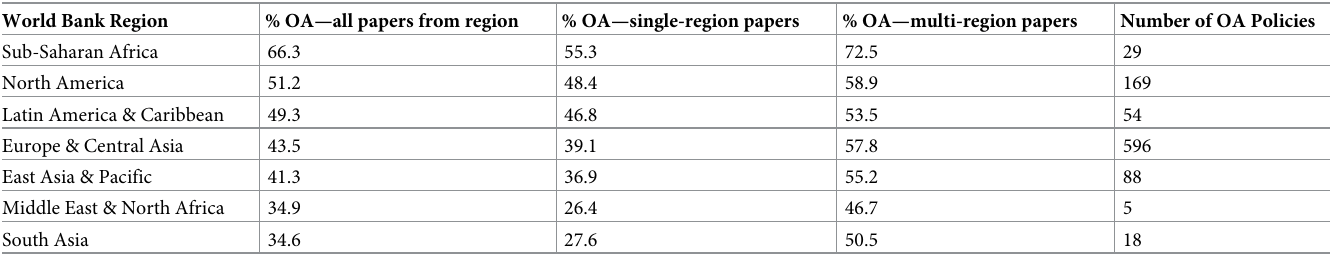
Authors’ countries of affiliation were binned by World Bank regions. The percentage OA by region is presented for three different groups of papers: papers with any affiliation in the region, papers with only that region in affiliations (single-region papers), and papers with that region and at least one other region of affiliation (multi- region papers). The number of OA policies tracked by ROARMAP [12] are also presented by region.